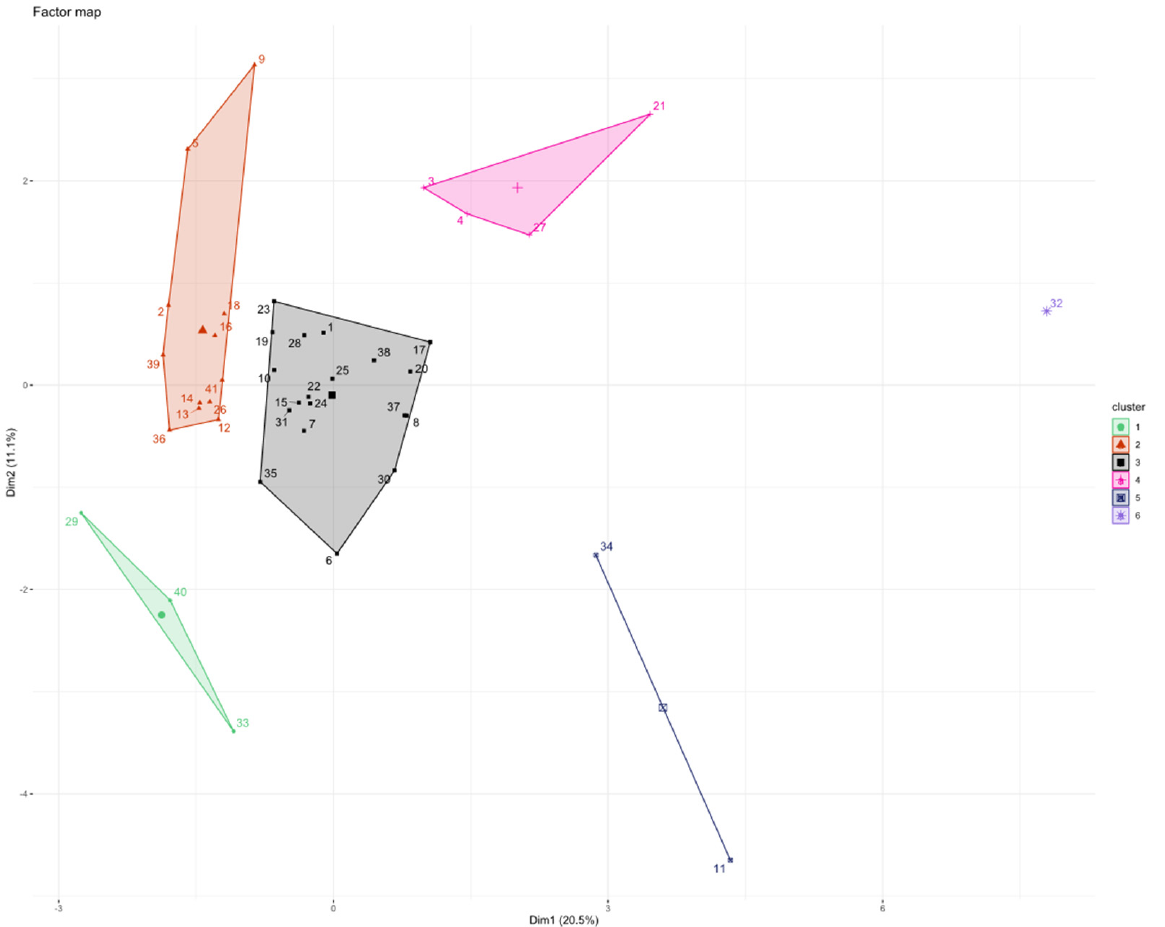
Figure 2. HCPC clustering with all cytokine values normalized at T0. On the x -axis is plotted first PC and on the y -axis second PC. Each patient is represented by a single dot number, labelled with a color of the cluster in which it belongs. Centroids are shown as bigger symbol with no number.